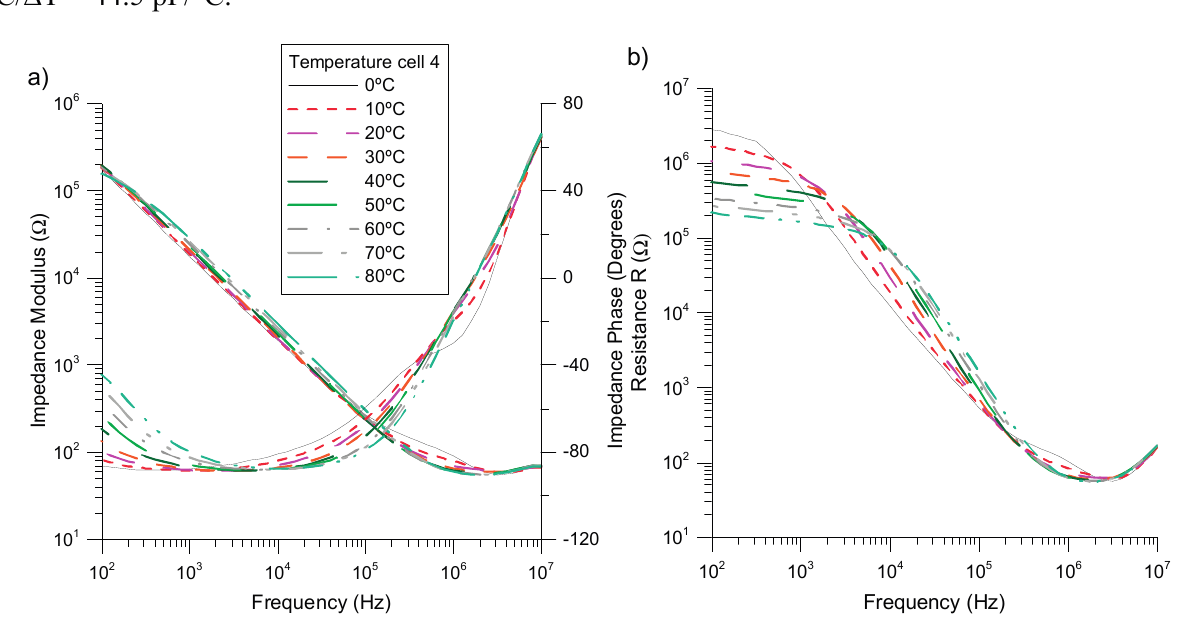
Figure 6. ( a ) Experimental complex impedance and ( b ) resistance of the NLC cell 4 as function of frequency for a temperature range of 0 °C to 80 °C.